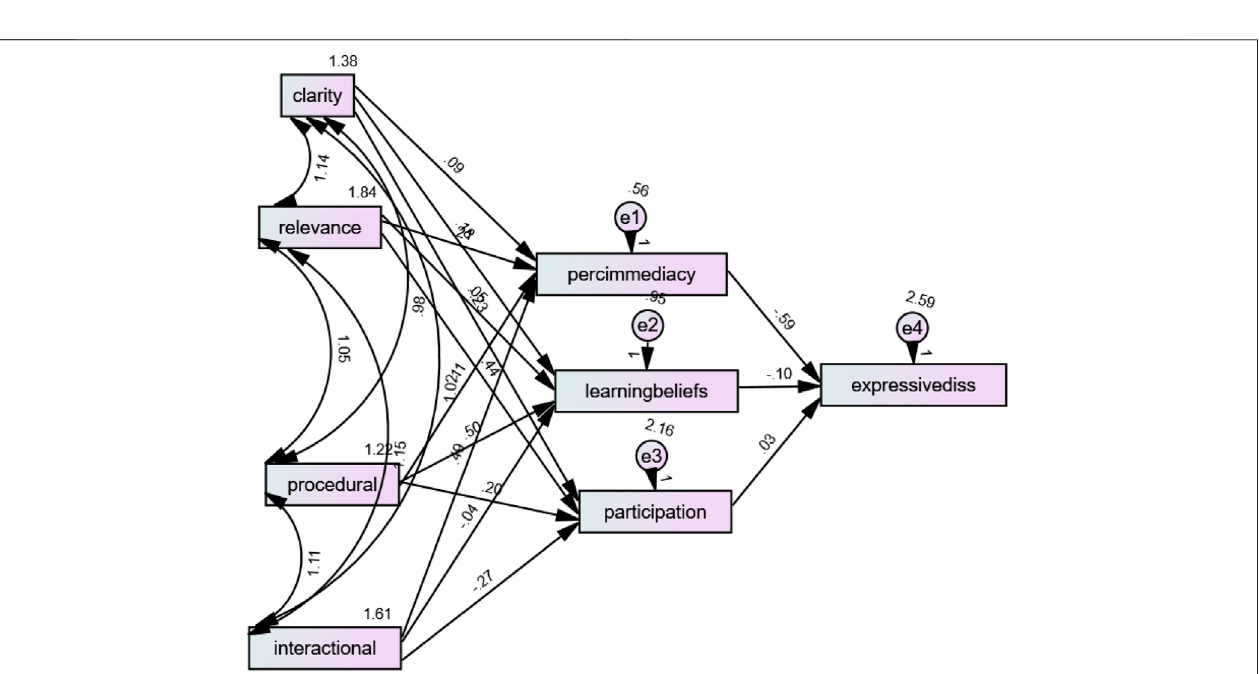
FIGURE 3 | Expressive dissent without class preference (Supported